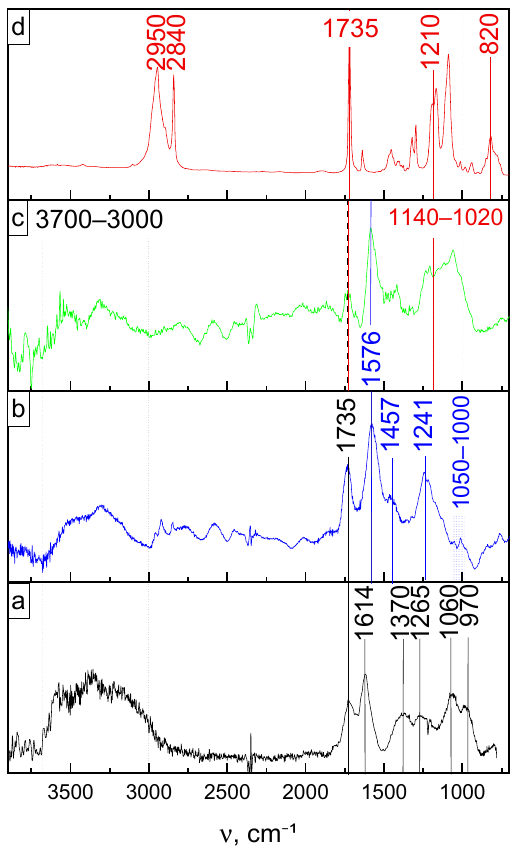
Figure 1. FTIR spectra of graphite oxide ( a ), r-GO ( b ), r-GO modified ( c ) with TMSPM ( d ). The r-GO was obtained in an H ₂ atmosphere.